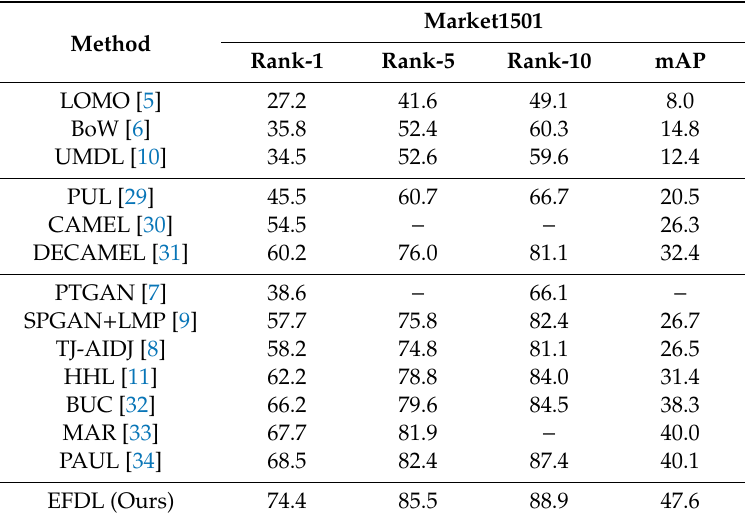
Table 1. Comparison with existing methods on Market1501.